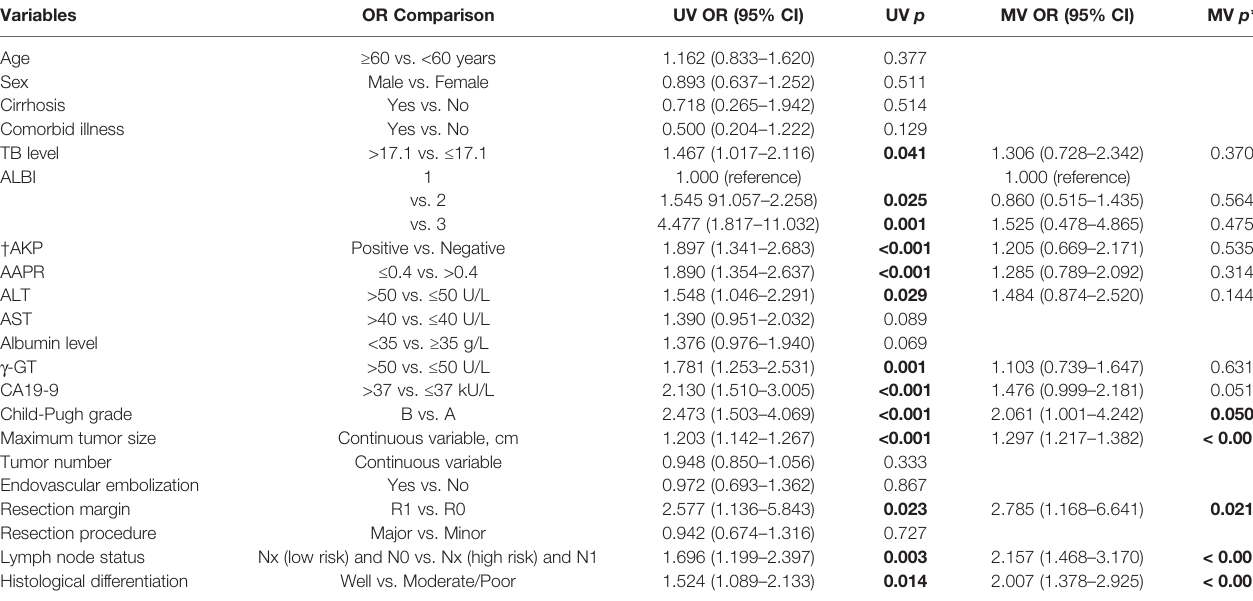
TABLE 2 | Univariable and multivariable Cox regression analysis of predicting outcomes in patients after resection for cholangiocarcinoma in the training